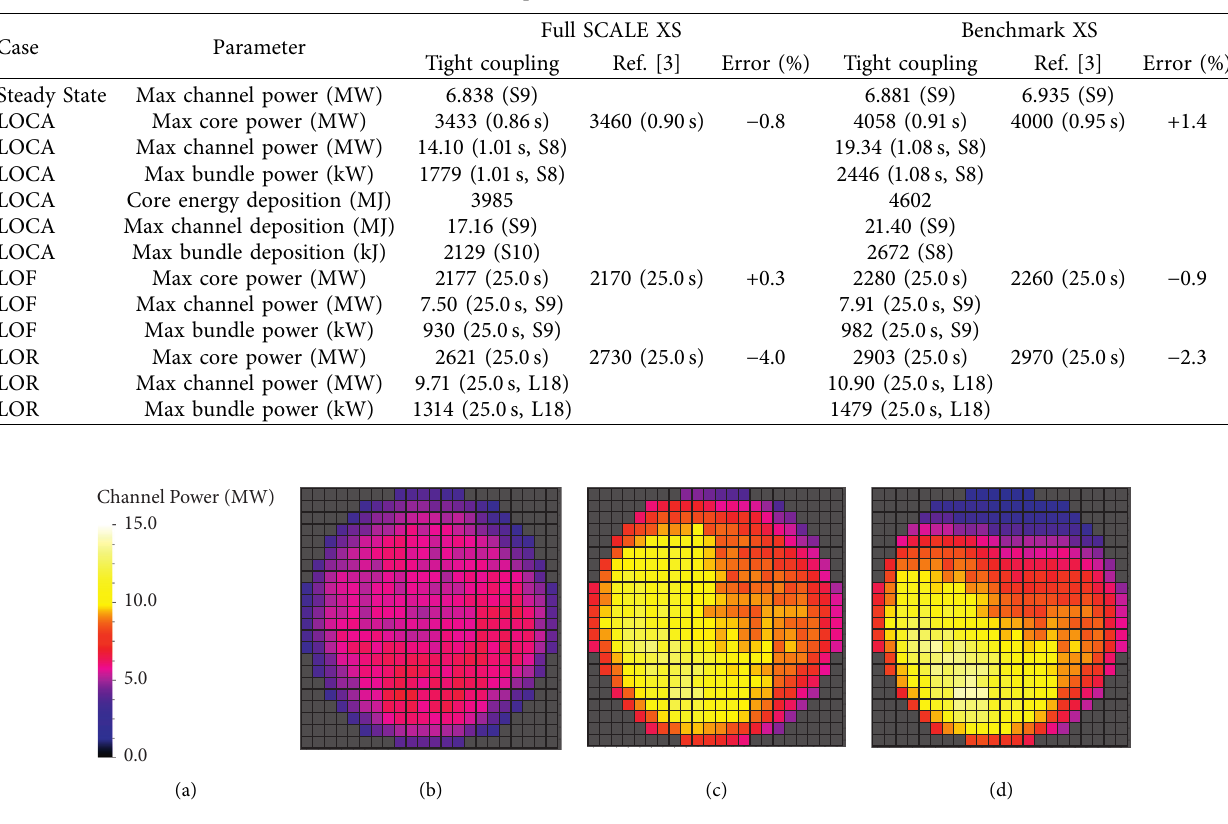
Table 2: Quantitative power results for ISCP benchmark model.